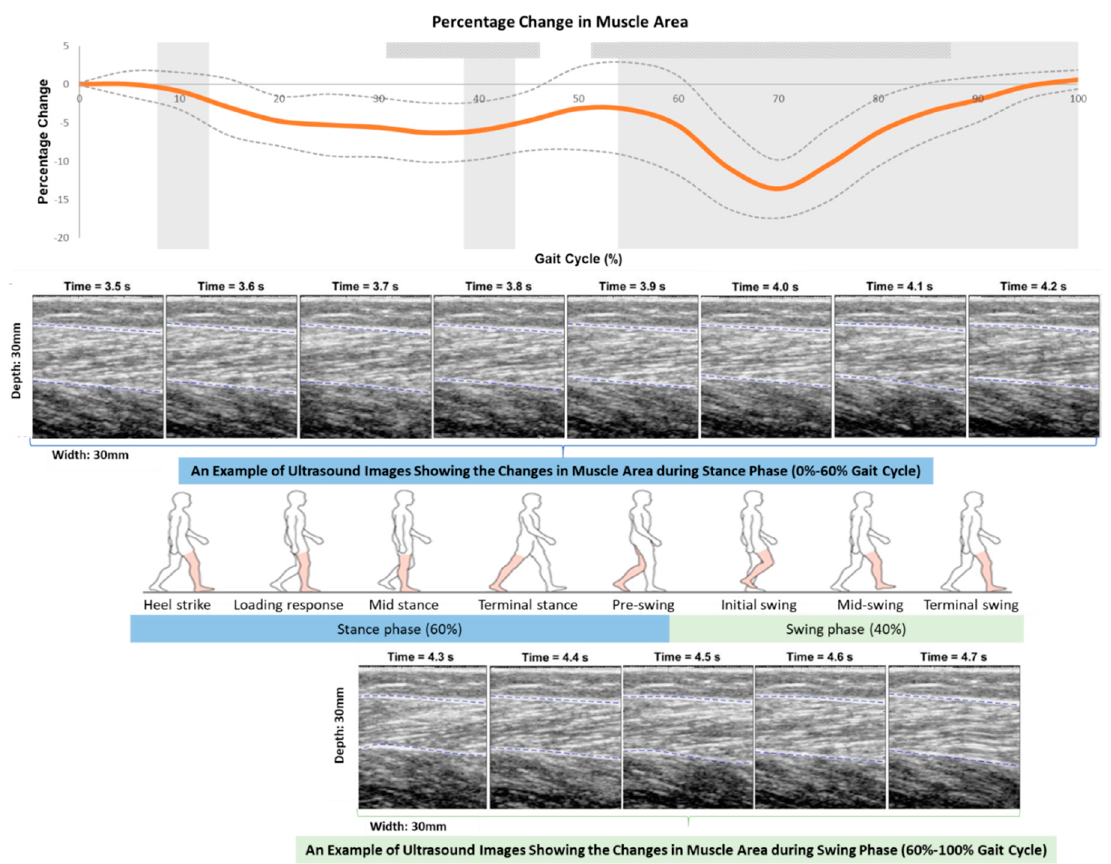
Figure 4. Ankle activities in a gait cycle measured by Vicon and the newly developed mobile SMG system of ten healthy subjects. P: P value; R: Pearson’s correlation coefficient; : significantly high correlation between the Vicon and mobile SMG systems; : significant changes in trend in consecutive 5% intervals; : significantly high correlation in intraclass correlation coefficient (ICC) among three trials; The bolded orange line illustrates the averaged data measured by the mobile SMG system; The bolded blue line illustrates the averaged data measured by the Vicon system; The thin dashed line illustrates the standard deviation (SD) of each corresponding bold line.